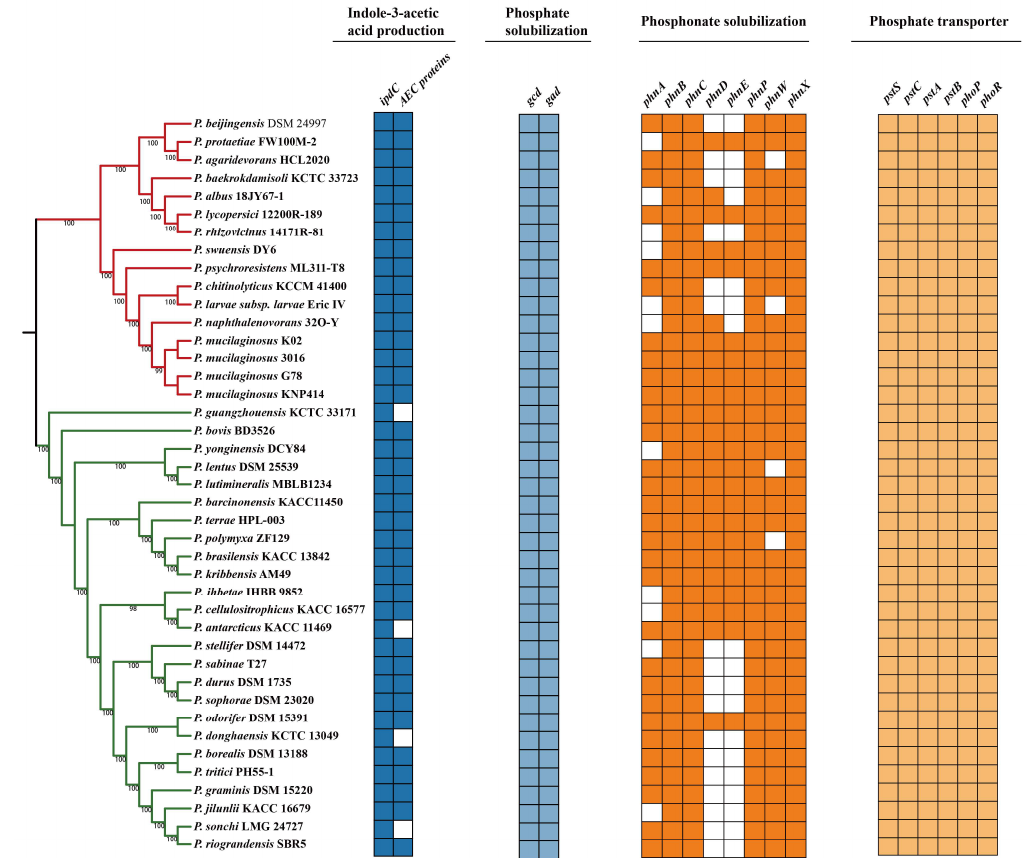
Figure 5. Genes involved in IAA production, organic and inorganic phosphate solubilization of 41 Paenibacillus strains. Colored box represents the presence of a gene within a genome and white box indicates absence of a gene.